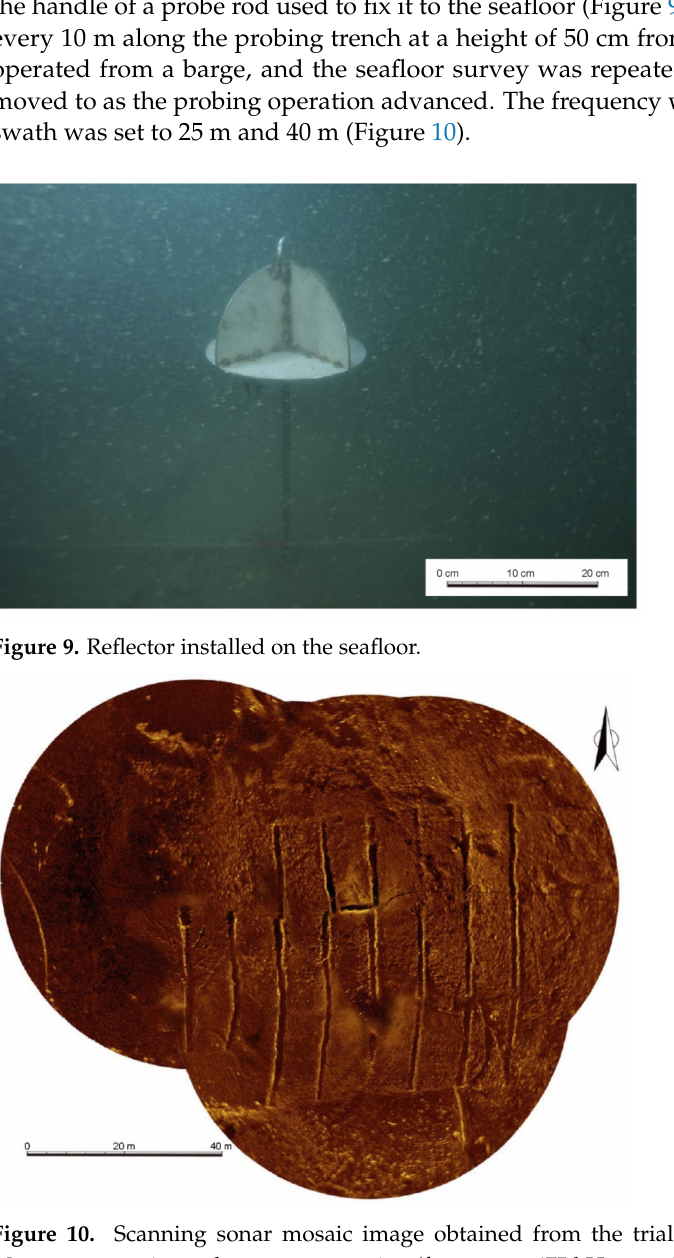
Figure 10. Scanning sonar mosaic image obtained from the trial excavation during the sixth Myeongnyang site underwater excavation (frequency: 675 kHz; swath 40